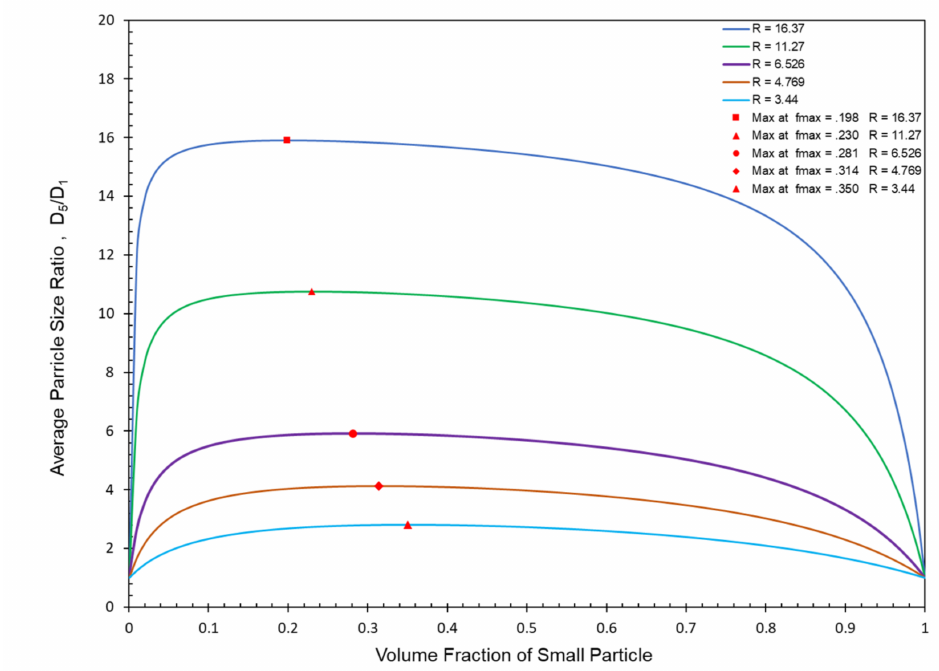
Figure 2. Average particle size ratio, D 5 /D 1 , for McGeary’s binary particle size ratios vs. volume fraction small particle (where R = D Large /D Small ).